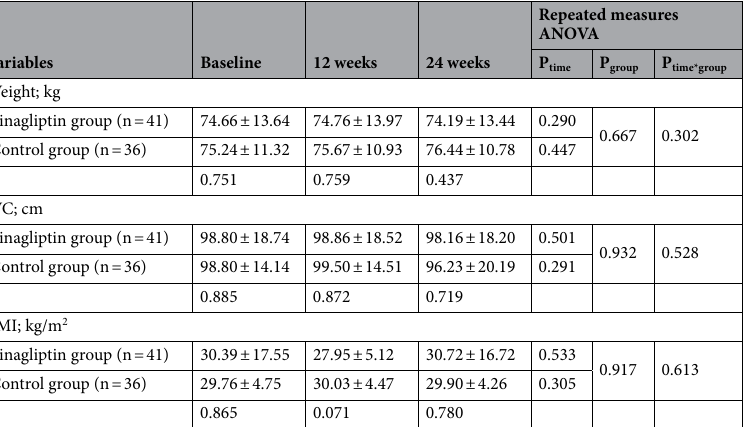
Table 2. Patients’ anthropometric parameters in two groups. Data are shown as mean ± SD. WC waist circumference, BMI body mass index. P is obtained from an independent samples t -test conducted for comparing the mean of the variables between the two groups at each follow-up time point. P group shows the overall difference between the two groups over the follow-up period. P time indicates the changes in the mean of the variables in the intervention and control groups over the follow-up period. P time*group presents the interaction between the time and intervention. P group , P time , and P time*group are obtained from repeated measures